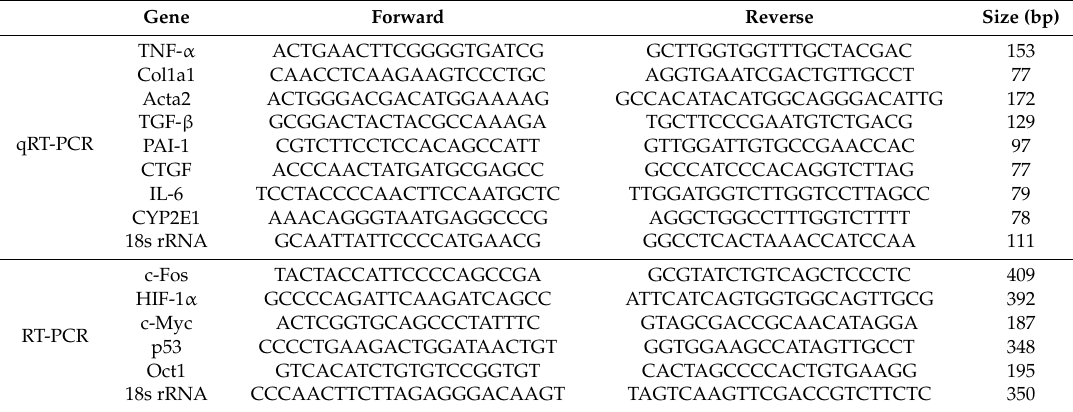
Table 1. List of